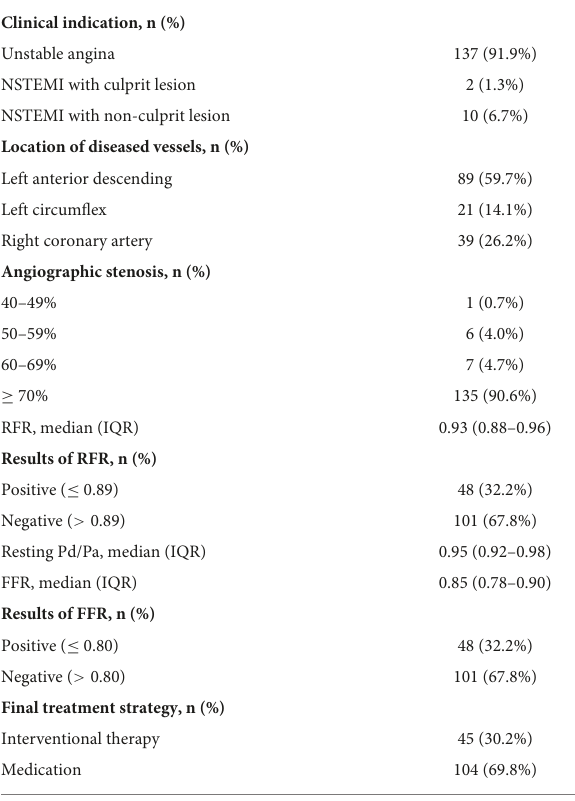
TABLE 2 Angiographic and physiological characteristics and treatment